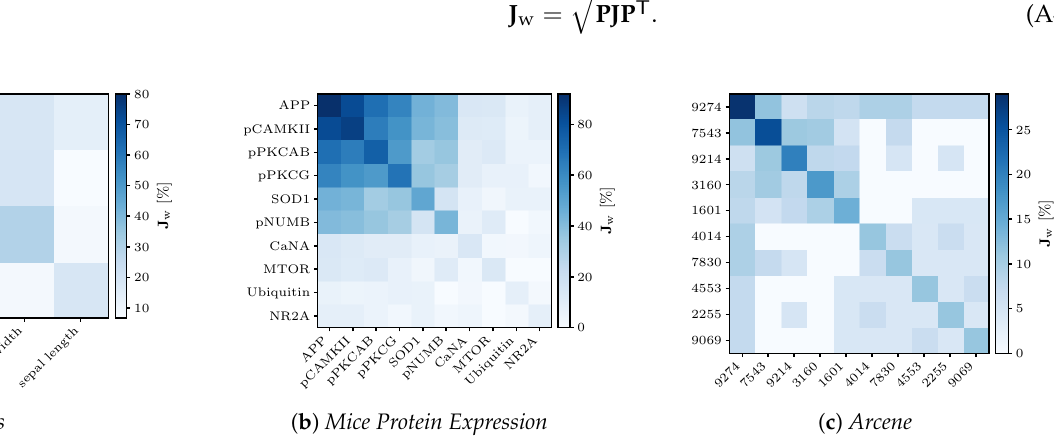
Figure A1. Weighted Jaccard matrices for all analyzed datasets. FeaSel-Net is applied 100 times on the Iris ( a ) and MPE ( b ) datasets and 35 times on the Arcene ( c ) dataset. Both MPE and Iris show features that are chosen very consistently (i.e., more than 80% of the FS runs). In the case of the MPE dataset, this means an increase of almost 1,500% compared to random guessing. For the Arcene set, it is even an increase of approximately